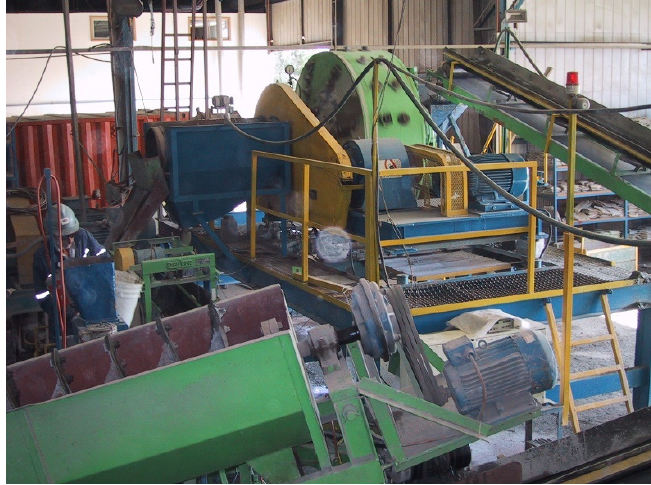
Figure 3. SAG mill, trommel, and spiral classifier.